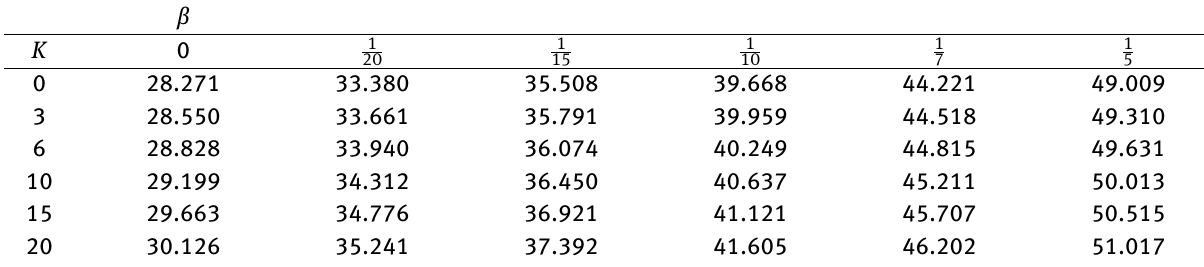
Table 5: Effect of length scale parameters on the critical buckling loads with different elastic medium parameter